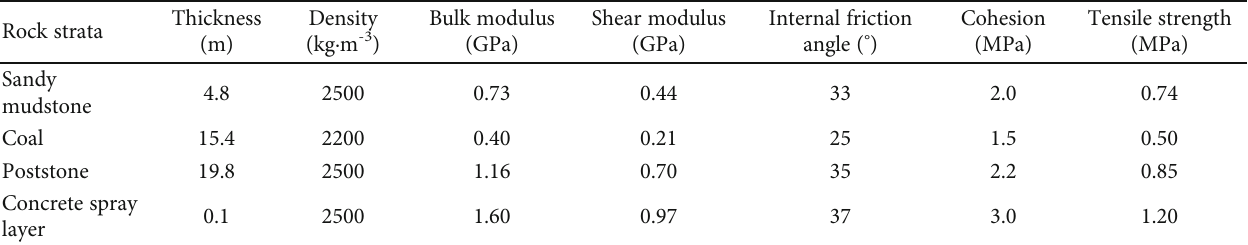
Table 2: Mechanical parameters of the surrounding rock and concrete spray layer.